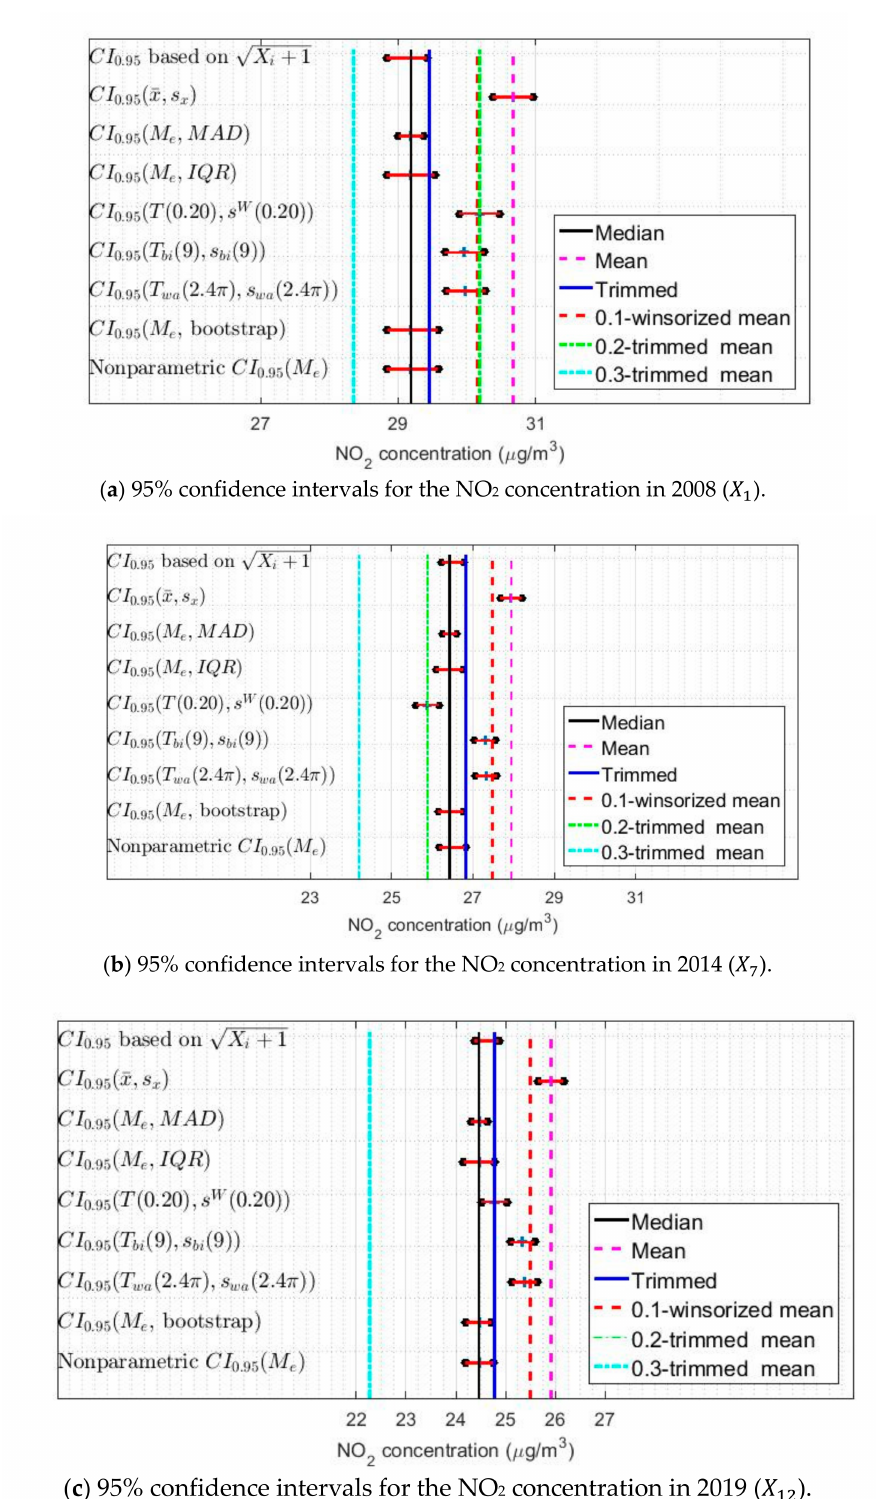
Figure 19. 95% confidence intervals ( CI 0.95 ): classic, classic based on data inversion of transformed data, robust, boostrap, and nonparametric confidence